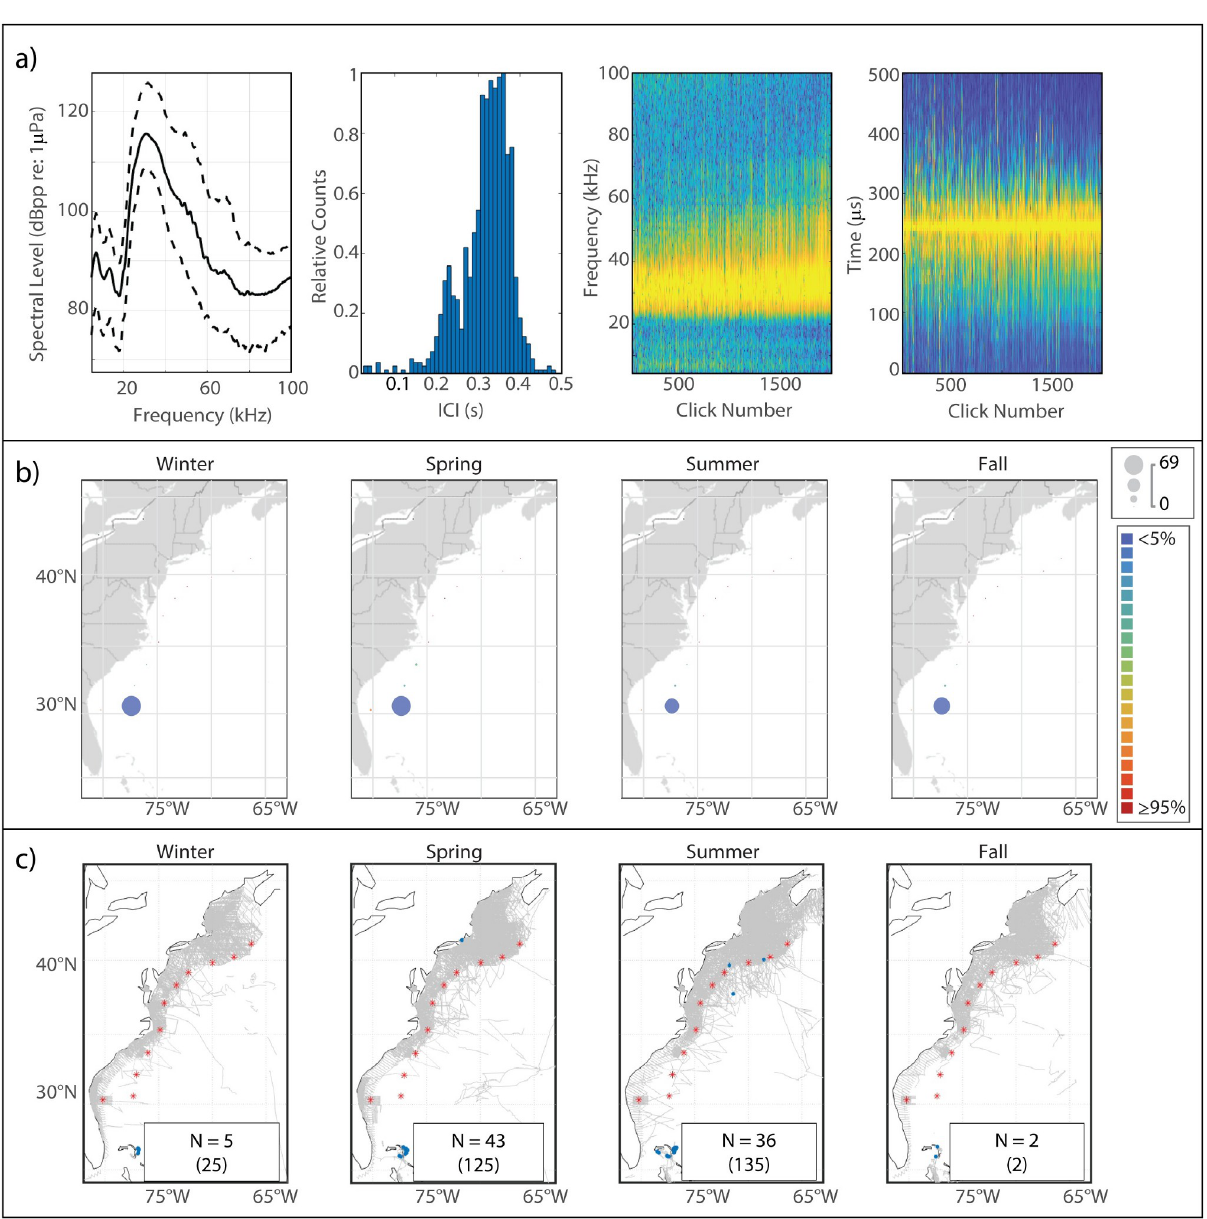
Fig 4. Results for Blainville’s beaked whale showing click type (a), acoustic presence (b), and historical sightings (c). Subplots as in Fig